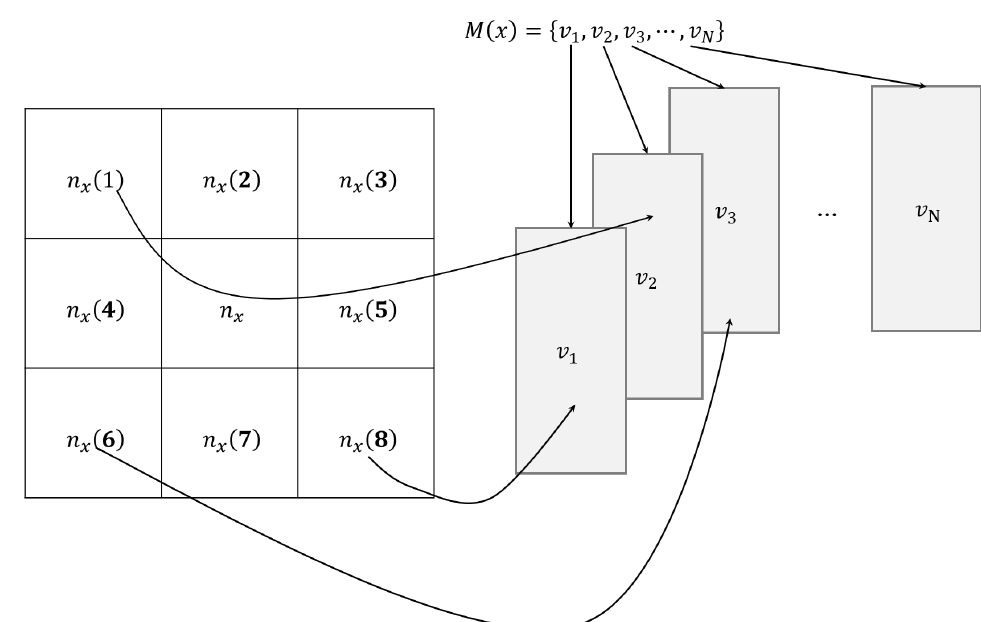
Figure 6. The construction diagram of pixel background sample set.